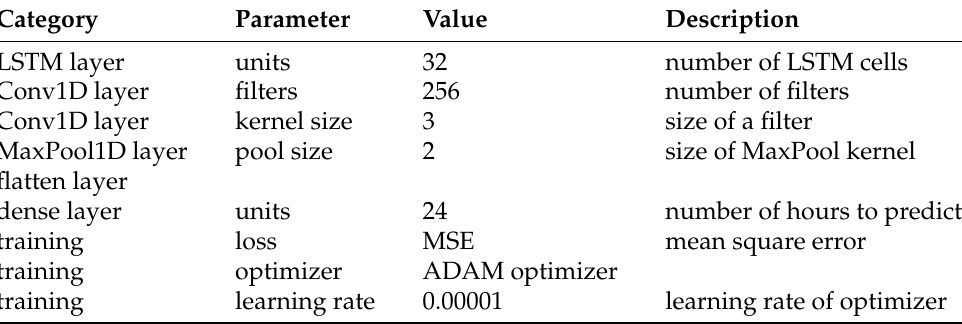
Table A5. Architecture of the LSTM convolutional